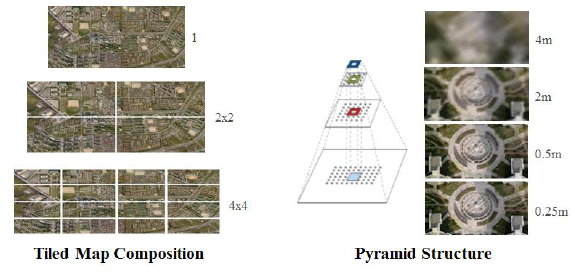
Figure 2. Tiled Map Pyramid Structure